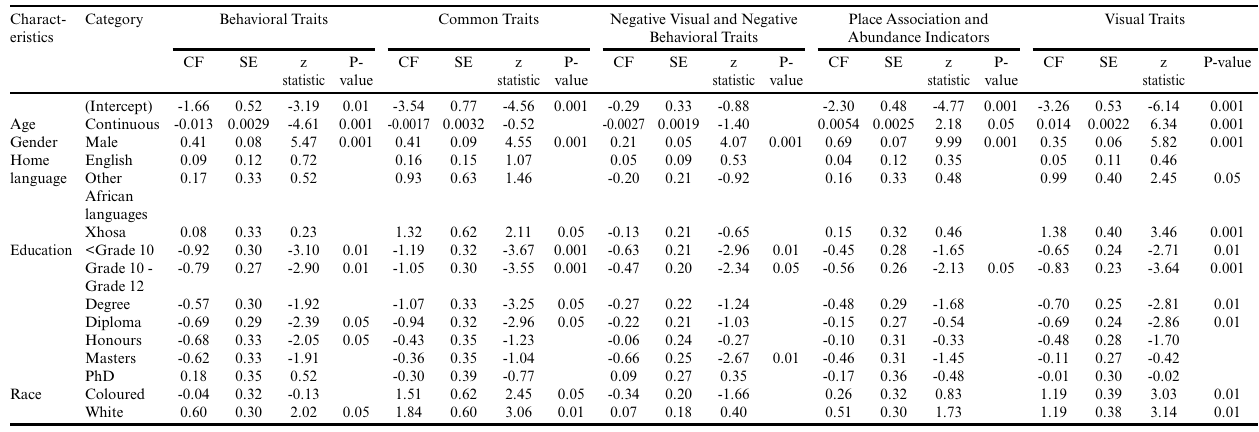
Table 2 . Regression coefficients (CF), standard error (SE), z-statistic, and p-value of the multinomial model between dimensions of socio-demographic characteristics and cultural functional groups. Socio-demographic characteristics missing p-values indicate non- significance (p >